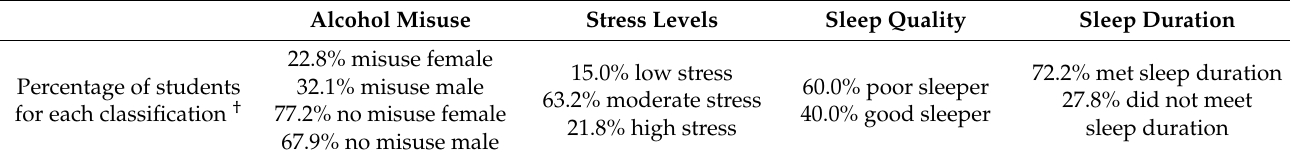
Table 4. Distribution of health behavior classifications.